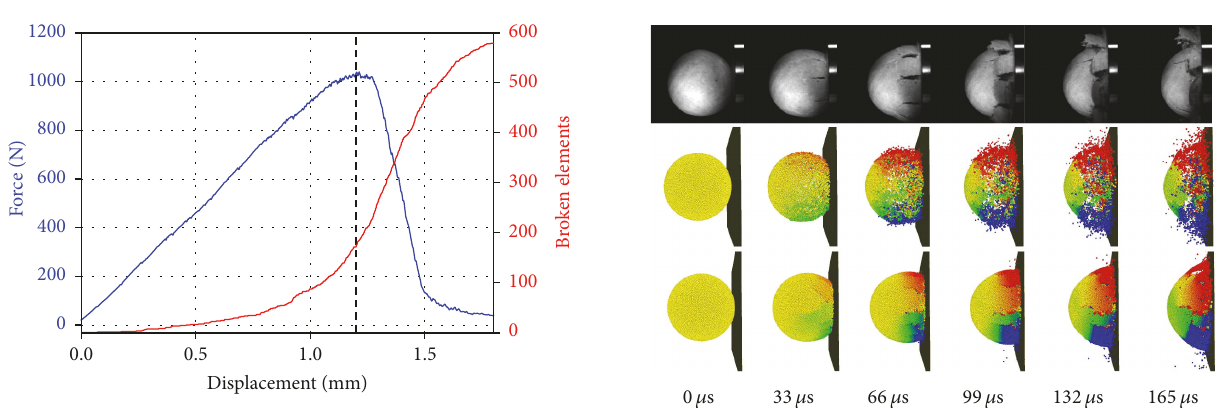
Figure 15: Hollow sphere impacting a rigid surface at 124 m ⋅ s −1 . From top to bottom: experimental results, strain rate independent, and strain rate dependent